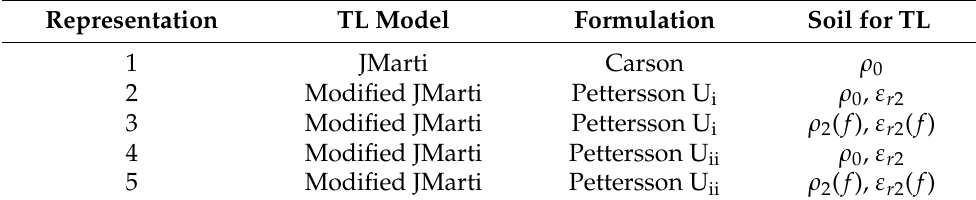
Table 3. Types of modeling